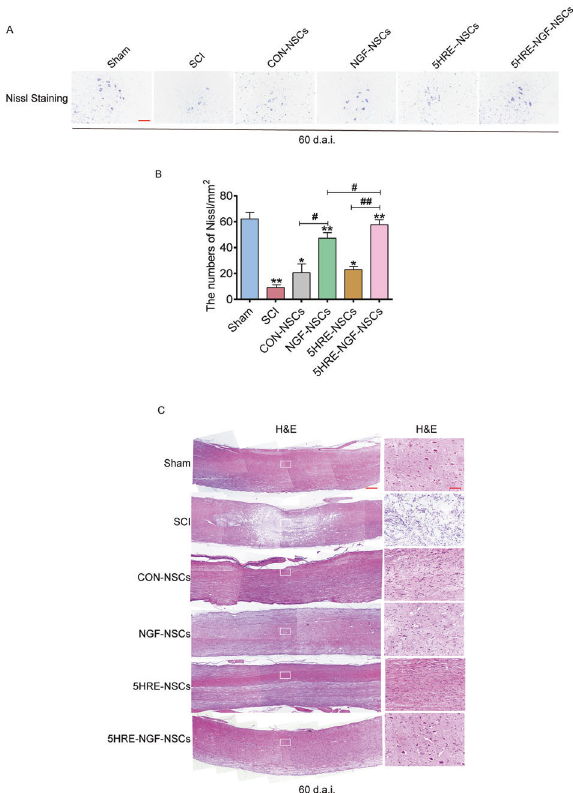
Fig. 5 5HRE-NGF-NSCs achieved the maximum in improving the recovery of SCI. A Nissl staining results of transection spinal cord for the Sham, SCI, CON-NSCs, NGF-NSCs, 5HRE-GFP-NSCs, 5HRE-NGF- NSCs group, scale bar = 500 mm. B Analysis of H&E and Nissl staining of sections. * and ** signify P < 0.05 or P < 0.01 versus the Sham group, “ # ” and “ ## ” signify P < 0.05 or P < 0.01 comparing between two groups. Data are the mean values ± SD, n = 6. C H&E and Nissl staining results of scored out spinal cord for the Sham, SCI, CON- NSCs, NGF-NSCs, 5HRE-NSCs, 5HRE-NGF-NSCs group, scale bar = 500 mm. Regions boxed manifests a representative region with higher power images, scale bar = 100